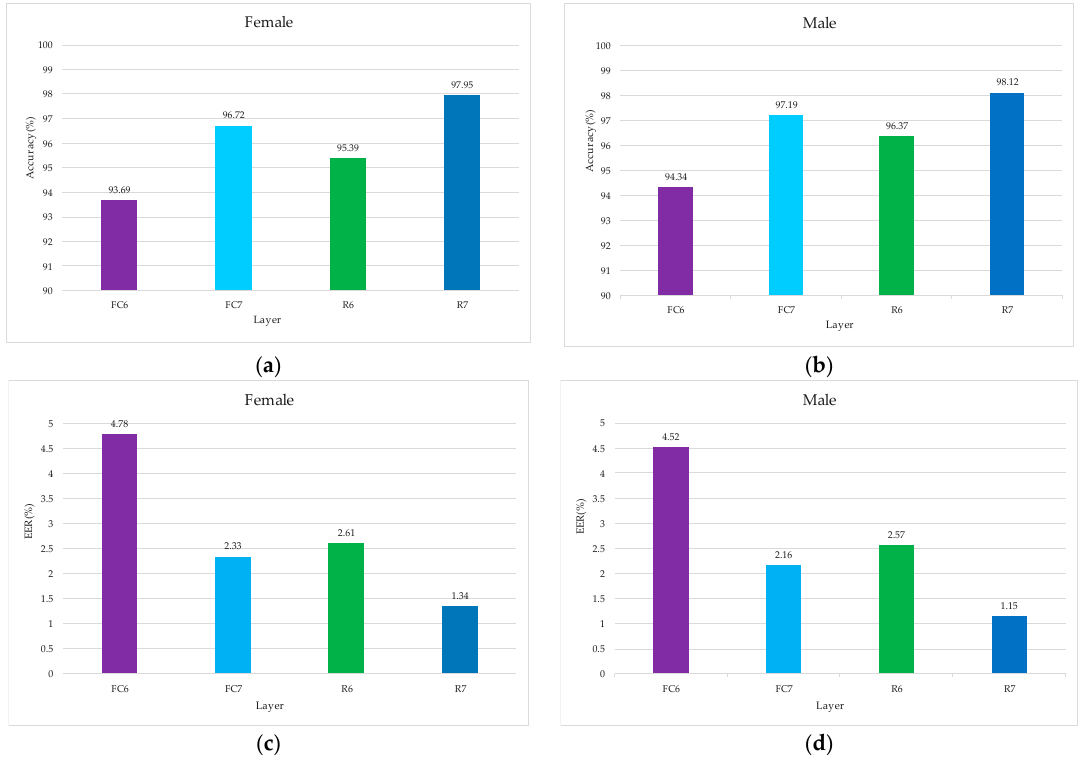
Figure 12. Contrast the influence of RBM and FC on voiceprint identification. ( a ) Comparison of accuracy for FC and RBM based on female, ( b ) comparison of accuracy for FC and RBM based on male, ( c ) comparison of EER for FC and RBM based on female, and ( d ) comparison of ERR for FC and RBM based on male.